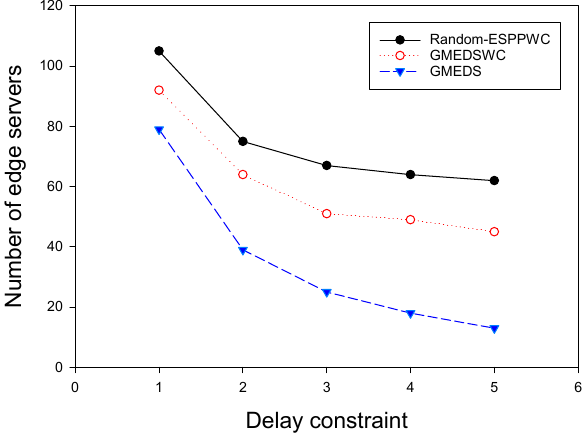
Figure 7. The impact of delay constraint with identical capacities.